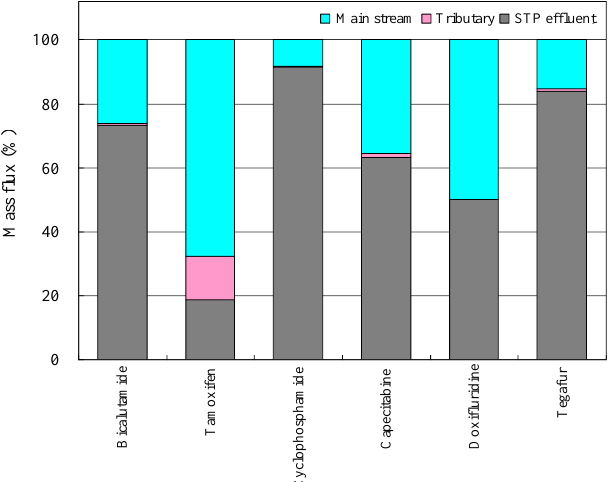
Figure 3. Source distribution of anticancer drugs in the Kanzaki–Ai River basin (abbreviation of each anticancer drug is shown in Table 1) (reproduced from [30]).